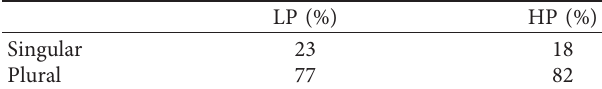
Figure 9: Correct mean % on noun inflection by number and animacy for HP. Table 6: Number errors for dual nouns by proficiency.